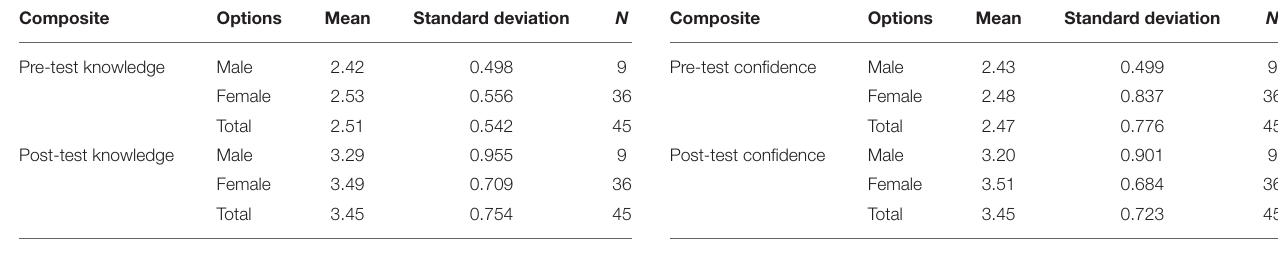
TABLE 3 | Confidence